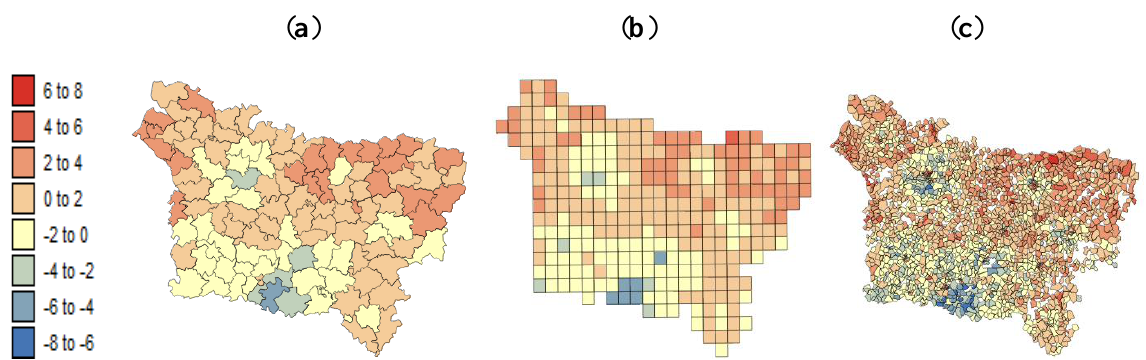
Figure 5. Maps of the deprivation index computed at three spatial scales: ( a ) county level; ( b ) grid level; ( c ) IRIS